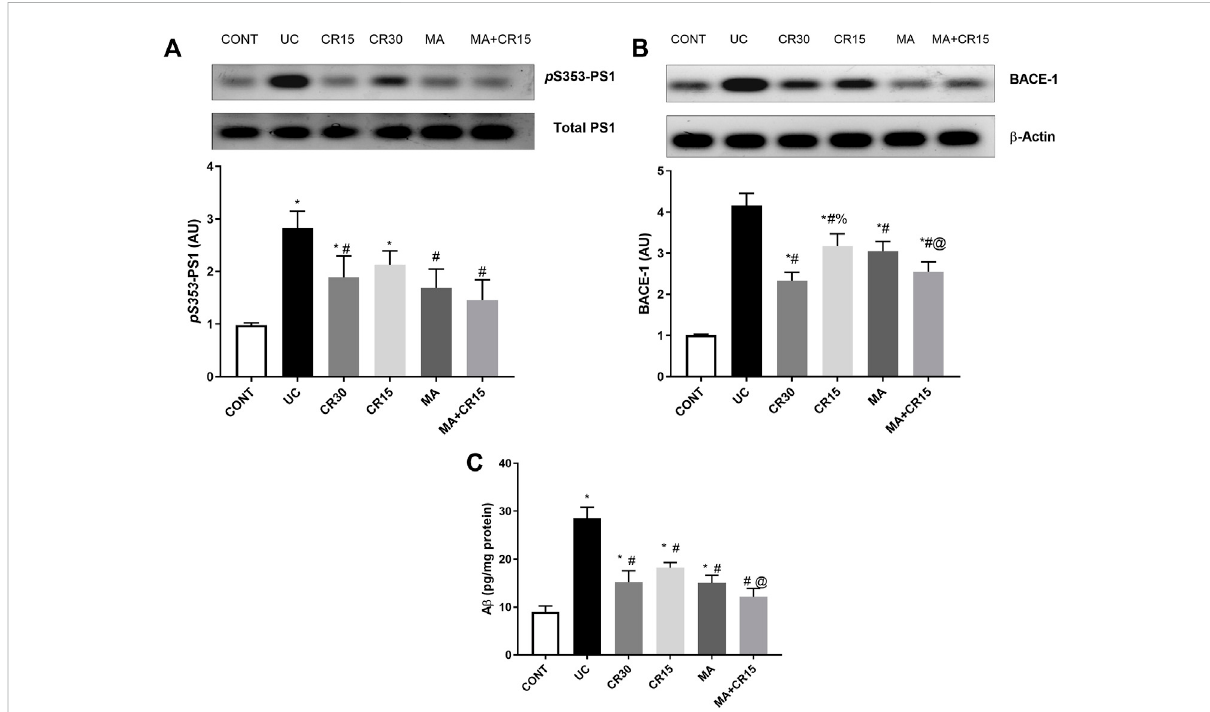
FIGURE 3 Effect of mirabegron and/or carvedilol on colon protein expression/content of (A) p (S353) -PS1, (B) BACE-1, and (C) A β (1 – 42) in rats with IAA- induced ulcerative colitis. Data are presented as mean ± SD (n = 4 – 6). Statistical analysis was carried out using one-wayANOVA followed by Tukey ’ s posthoc test; p < 0.05. As compared to the (*) CONT, (#) UC, and (@) CR15 groups. A β , beta-amyloid; BACE-1, beta-site APP-cleaving enzyme; CONT, control; CR, carvedilol; IAA, iodoacetamide; MA, mirabegron; PS1, presenilin; UC, ulcerative